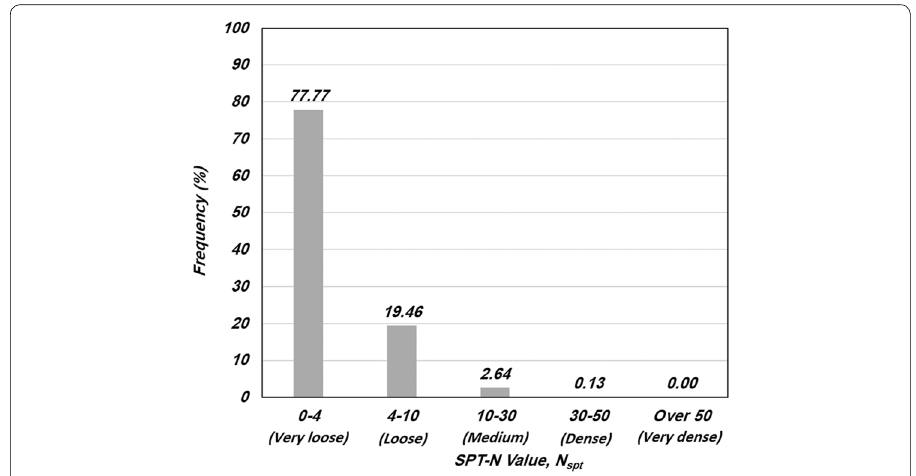
Fig. 6 Histogram of 4543 in situ SPT N‑value records of sand